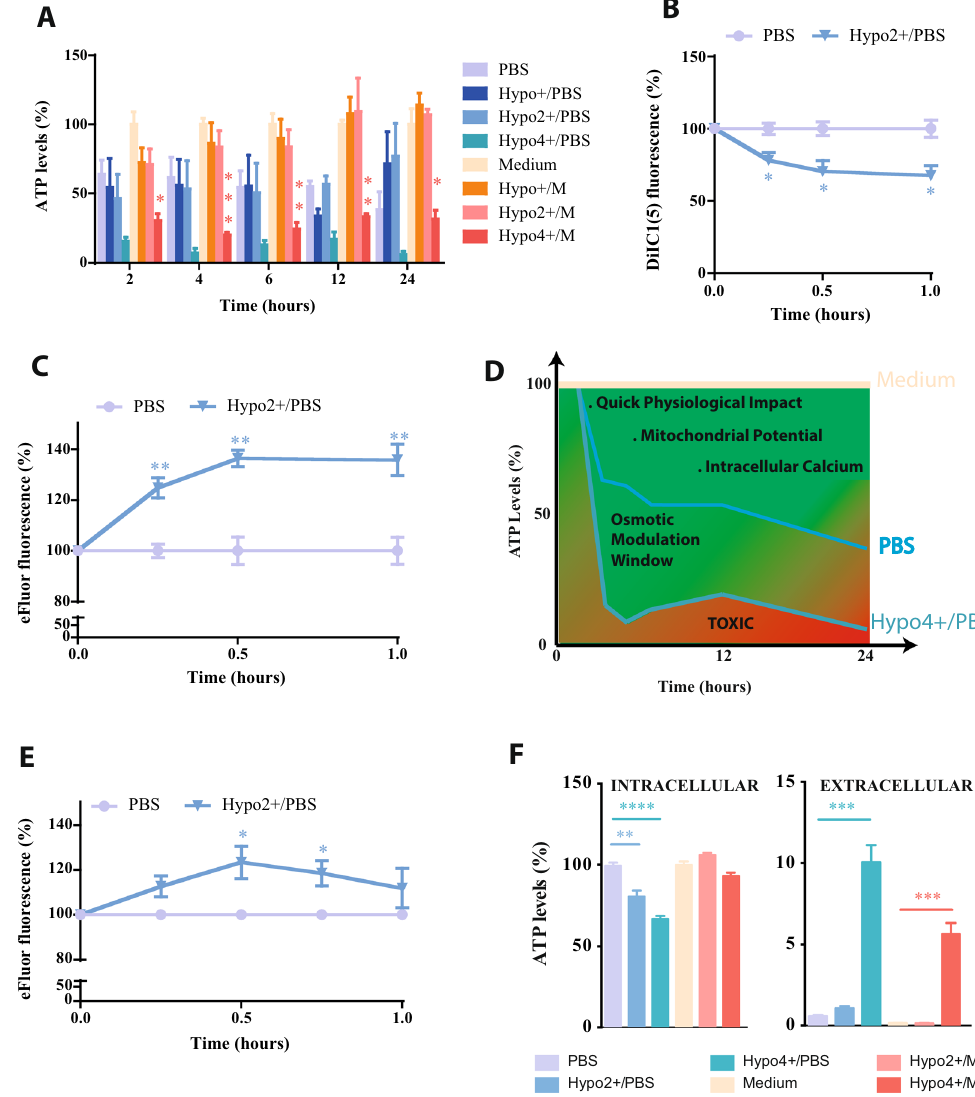
Figure 1. Impact of different osmotic environments in K562 cell physiology. ( A ) to ( C ) Effect of constant osmotic modulation on ATP levels (% normalised by medium condition), mitochondrial membrane potential (DiIC1(5)) and intracellular free calcium levels (e-Fluor) (% of fluorescence signal normalised to the control). ( D ) Schematic representation of the safety of the PBS-based hyposmotic modulation strategy. This scheme is derived from ( A ) and highlights the deleterious effect that even PBS by itself has in permanent culturing conditions. ( E ) and ( F ) Effect of transient osmotic modulation (15 minutes) on intracellular free calcium levels (e-Fluor) and intracellular vs extracellular ATP levels (% normalised to the medium/PBS condition). The different osmotic modulation protocols are described in the legend of each graph. The variations presented are the mean value ± SEM (n ≥ 3) and the changes are statistically significant at the time points highlighted in the graphs ( * p value < 0.05; ** p value < 0.01; *** p value < 0.001; **** p value <